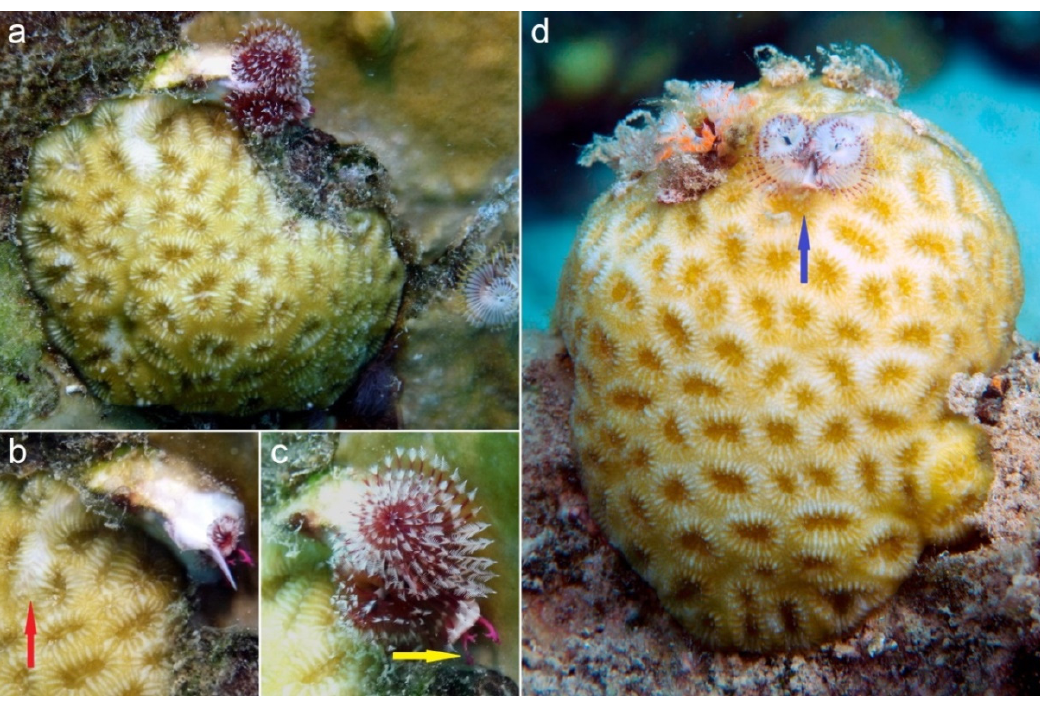
Figure 2. Favia fragum hosting Spirobranchus spp. at 3–4 m depth, dive site “Front Porch” (12°09' 54" N 68°17'12" W), Bonaire, Southern Caribbean (2019). ( a – c ) Spirobranchus giganteus : overall view ( a ), overgrown tube section indicated by red arrow ( b ); antler-shaped opercular spines showing dark pink coloration indicated by yellow arrow ( c ). ( d ) Spirobranchus polycerus : two individuals, one showing white spines on its operculum (blue arrow).